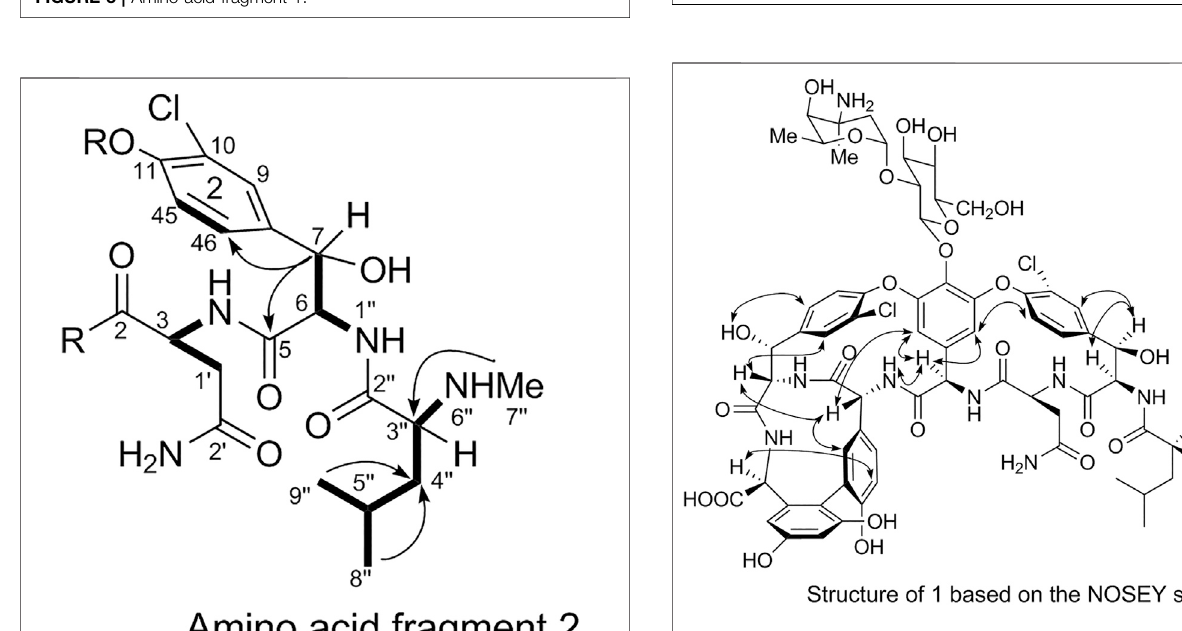
FIGURE 3 | Amino acid fragment 1.